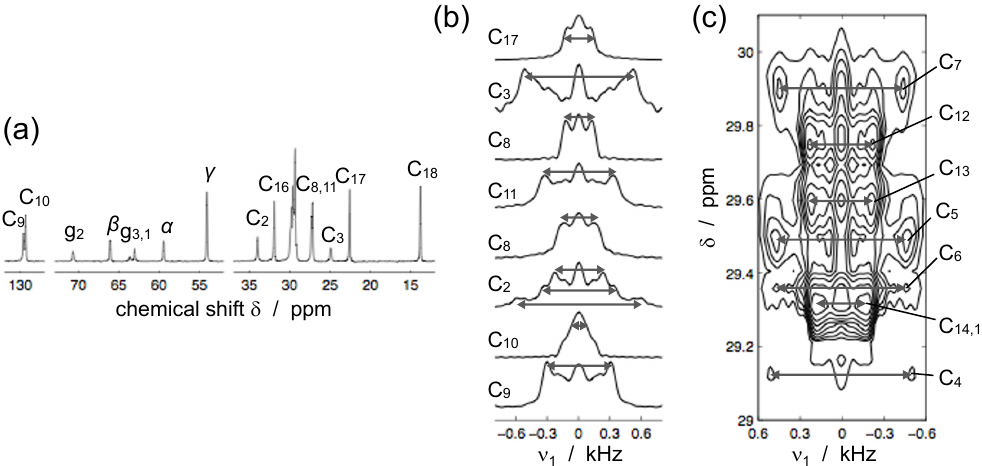
Figure 14. R-PDLF dipolar profile of DOPC MLVs at 37 ◦ C. ( a ) 1 H– 13 C refocused INEPT spectrum with labels for the distinct dioleoylphosphatidylcholine (DOPC) carbons; ( b ) Dipolar slices of the R-PDLF spectrum at the 13 C chemical shifts of the indicated carbons showing distinct dipolar splittings; ( c ) Contour plot of the crowded spectral region with highly resolved splittings. The assignment was based on a previous determination done for POPC MLVs